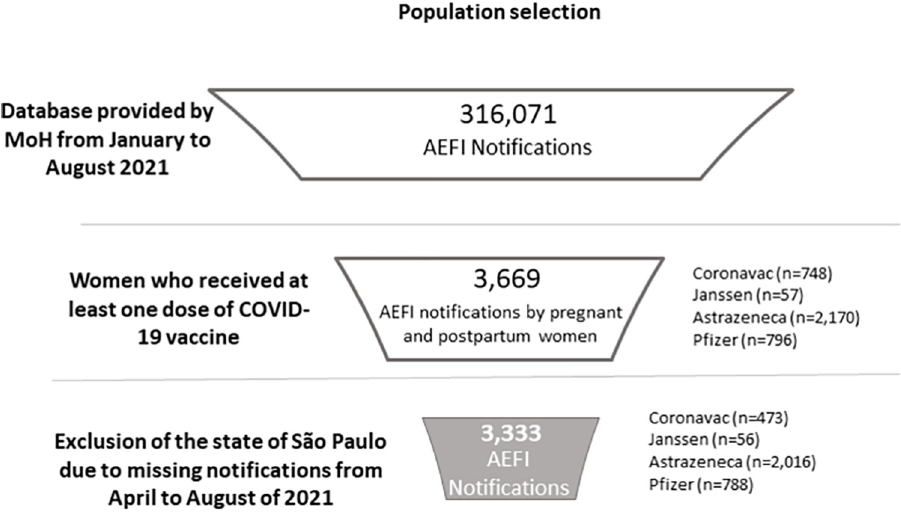
Fig 1. Attrition